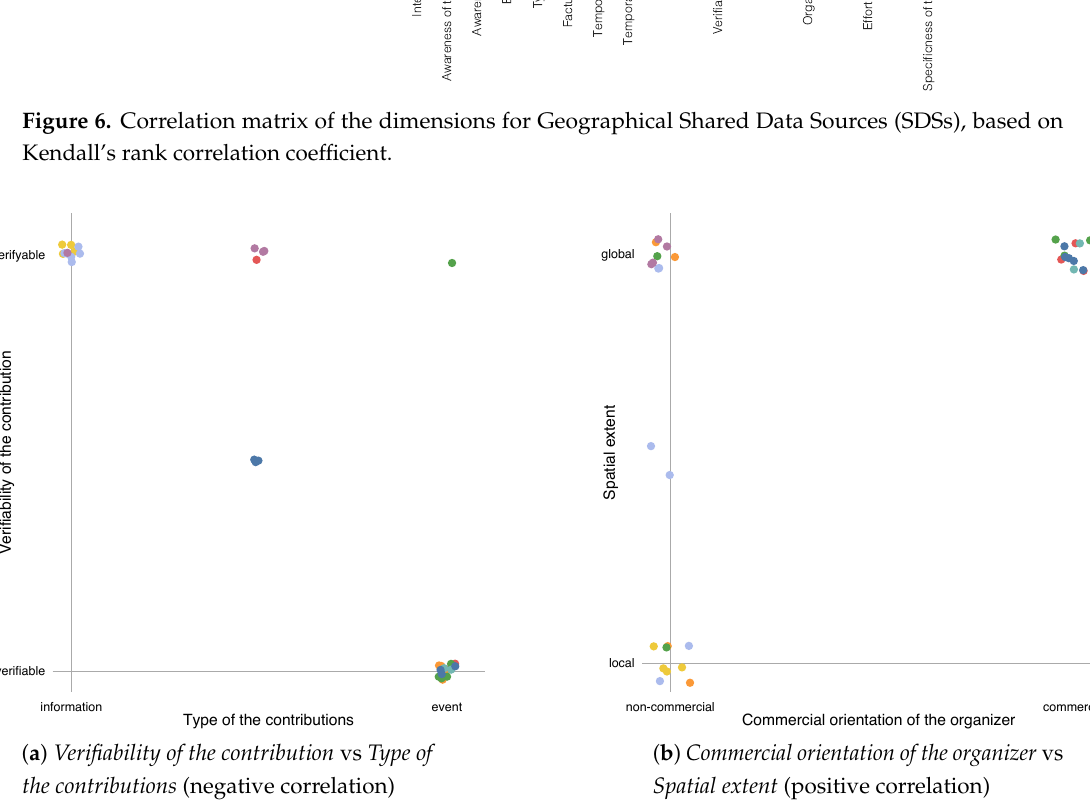
Figure 7. Scatter plots for selected pairs of dimensions for Geographical Shared Data Sources (GSDSs). The legend for the categories can be found in Figure 2. The data has been normalized and slightly